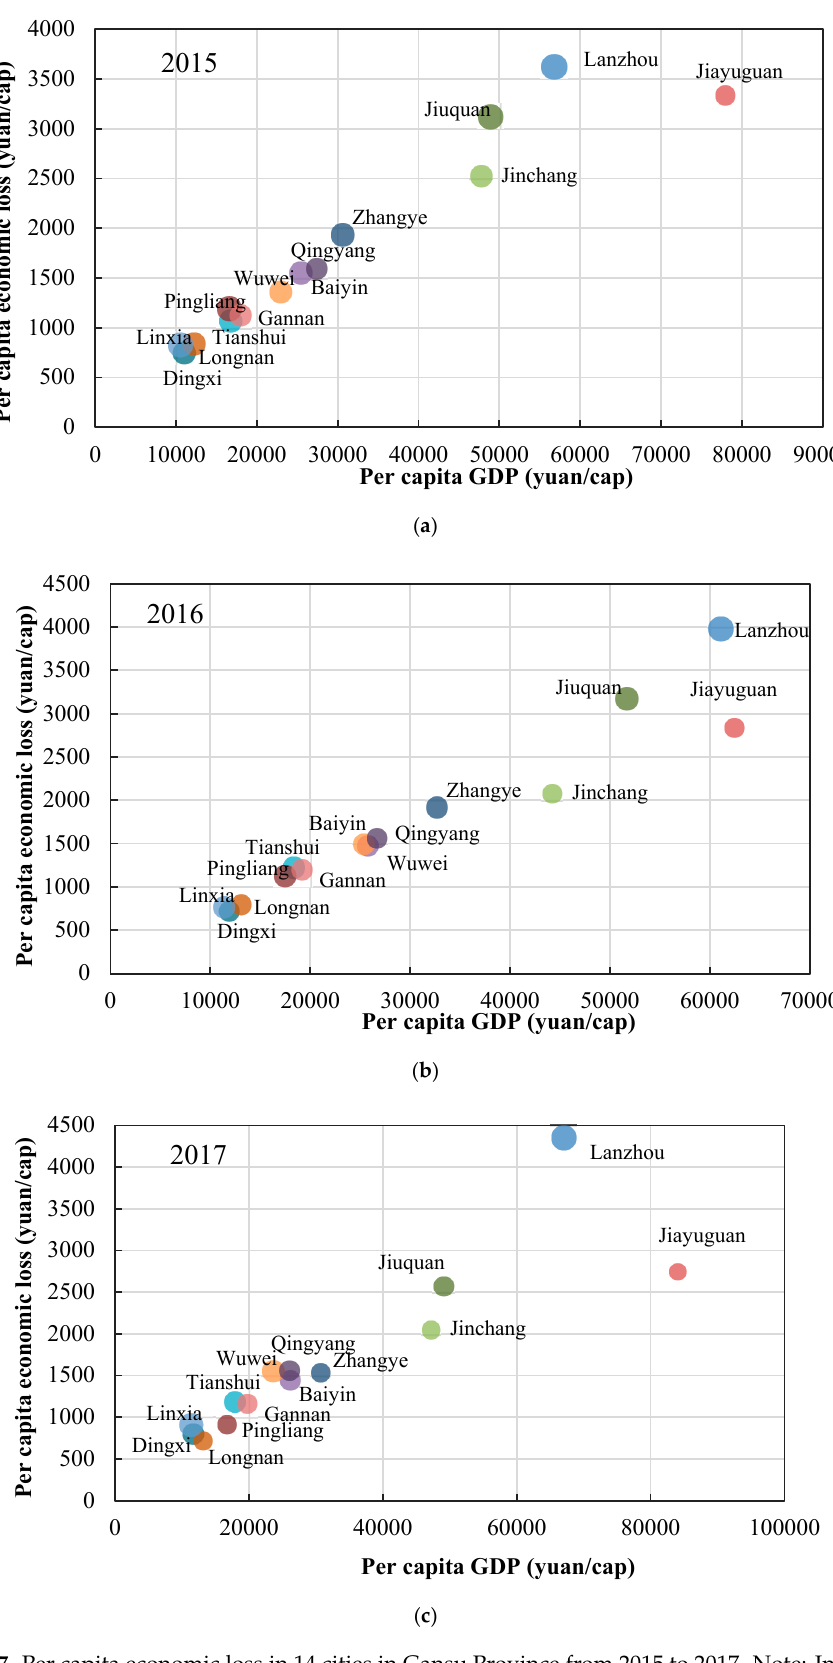
Figure 7. Per capita economic loss in 14 cities in Gansu Province from 2015 to 2017. Note: In Figure 7, the size of the circle represents PM 2.5